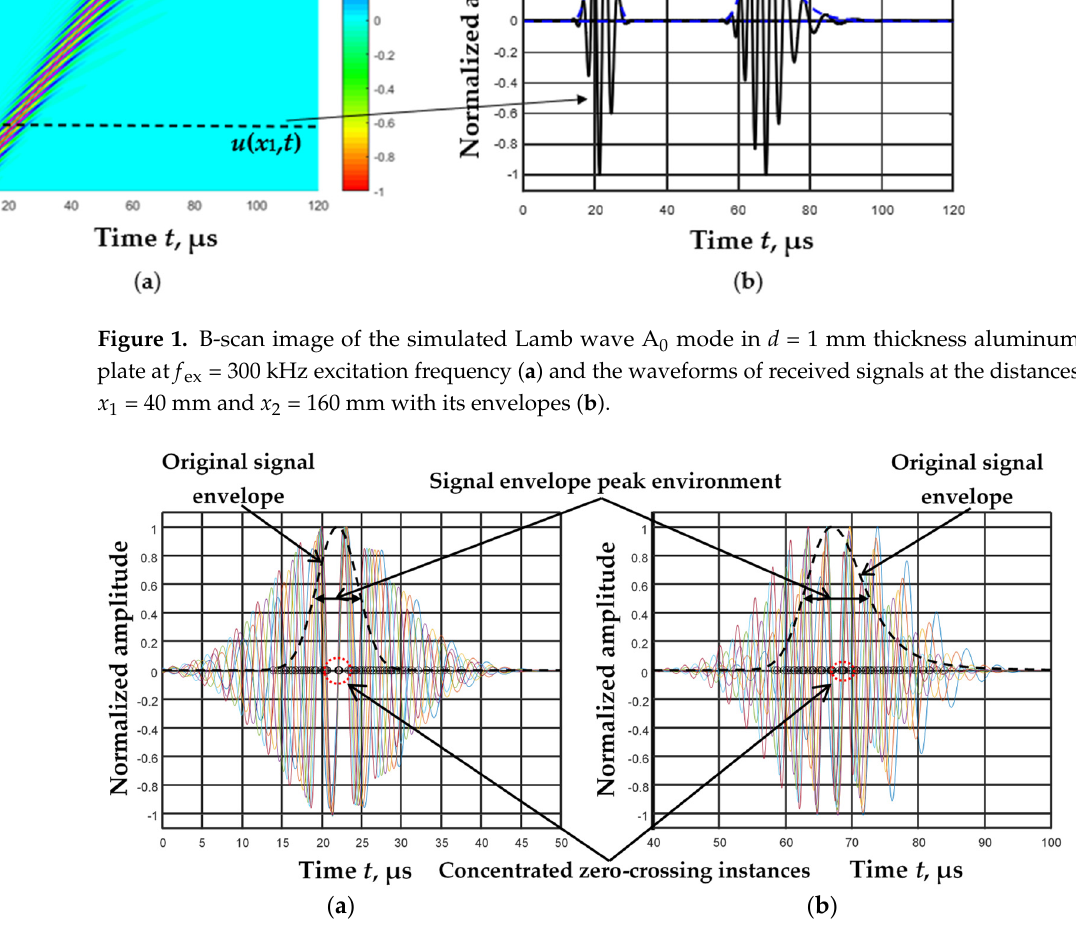
Figure 2. Signals filtered by means of five filters (color curves) s i ( x , t ) at the distances x 1 = 40 mm ( a ) and x 2 = 160 mm ( b ) with the envelopes of the original signals u ( x , t ).